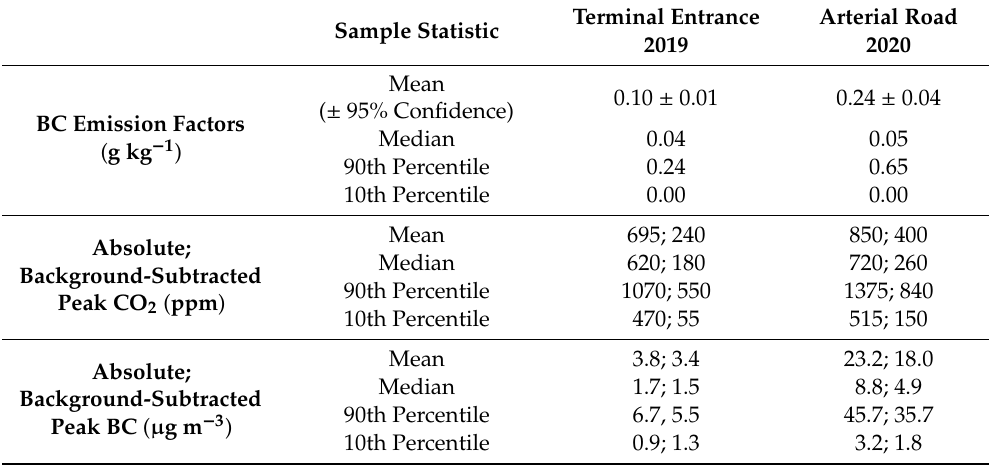
Table A1. Summary of BC emission factors and peak CO 2 and BC concentrations at the Terminal Entrance 2019 and Arterial Road 2020 sampling locations measured with the AE33 and